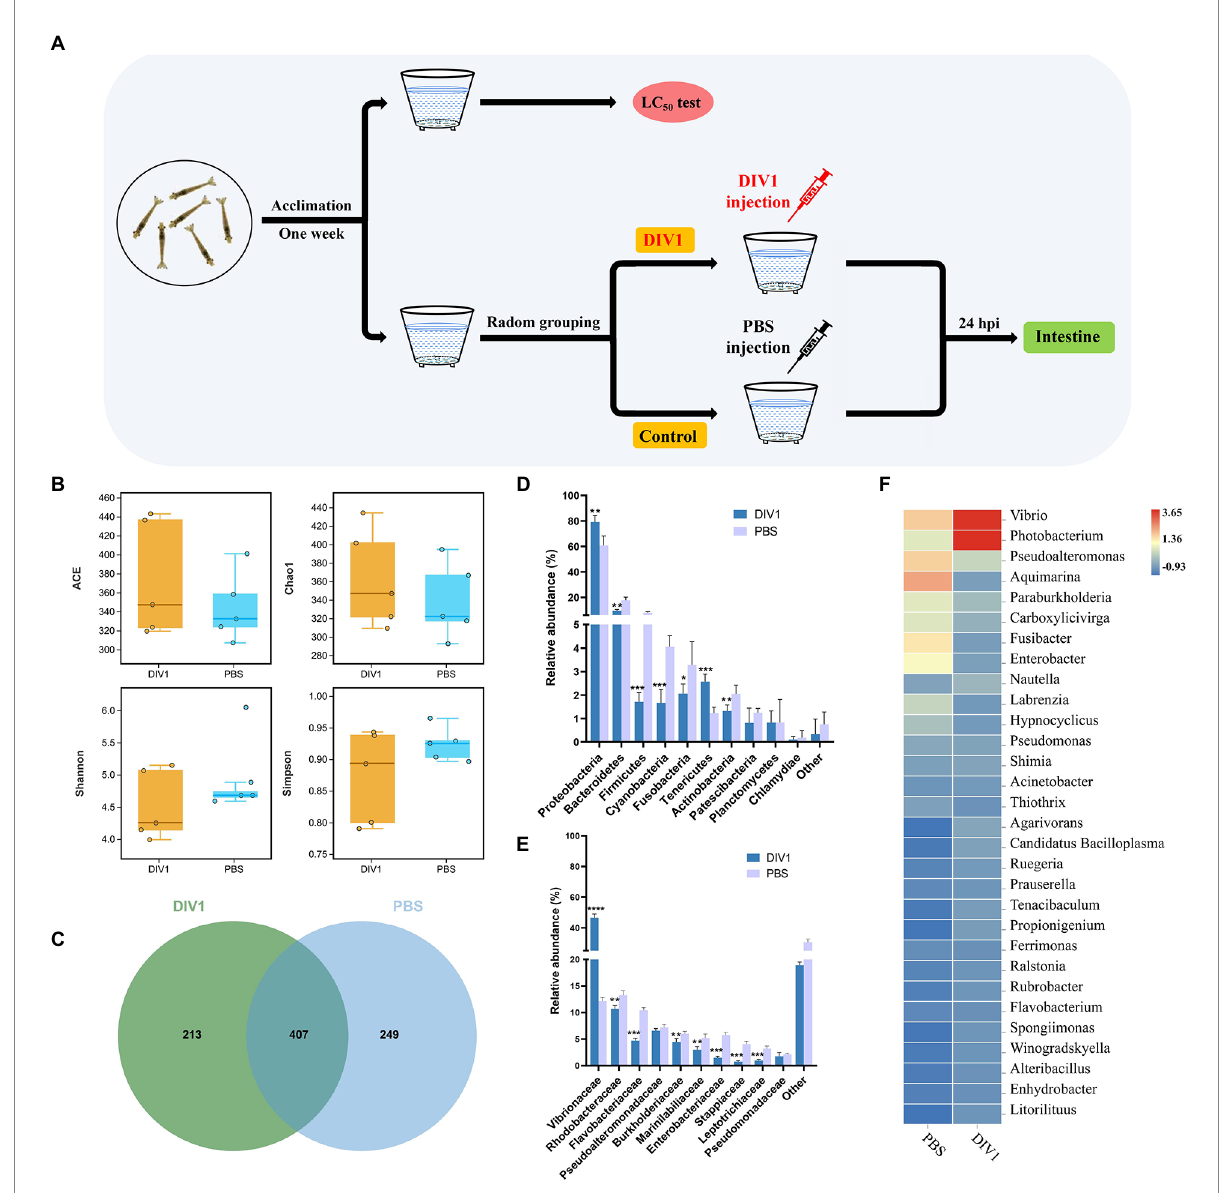
FIGURE 1 The diversity and bacterial composition of intestinal microbiota in M. ensis after DIV1 infection. (A) Schematic diagram of the experimental setup. (B) Alpha diversity indices for the DIV1-infected and PBS groups. Bars indicate mean ± S.D. ( n = 5). (C) Venn figure showing the unique and shared OTUs of microbiota in DIV1-infected and PBS groups. Display the relative abundance of intestine microbial at the phylum (D) and family (E) classification level. Bars are shown as mean ± S.D. ( n = 5). * indicate significant differences between groups. * p < 0.05, ** p < 0.01, *** p < 0.001 and **** p < 0.0001. (F) Heatmap analysis of the top 30 microorganisms at the genus level. Blue colors indicate lower abundance, and red colors indicate higher abundance. Standardized by